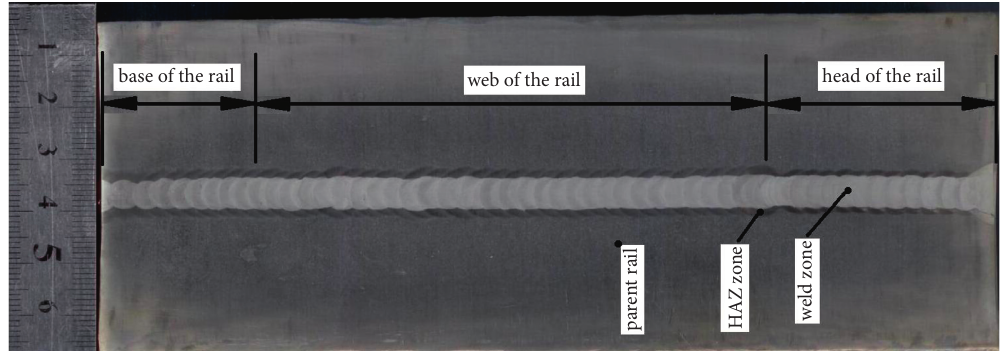
Figure 3: Macroscopic picture of the rail weld joint cross